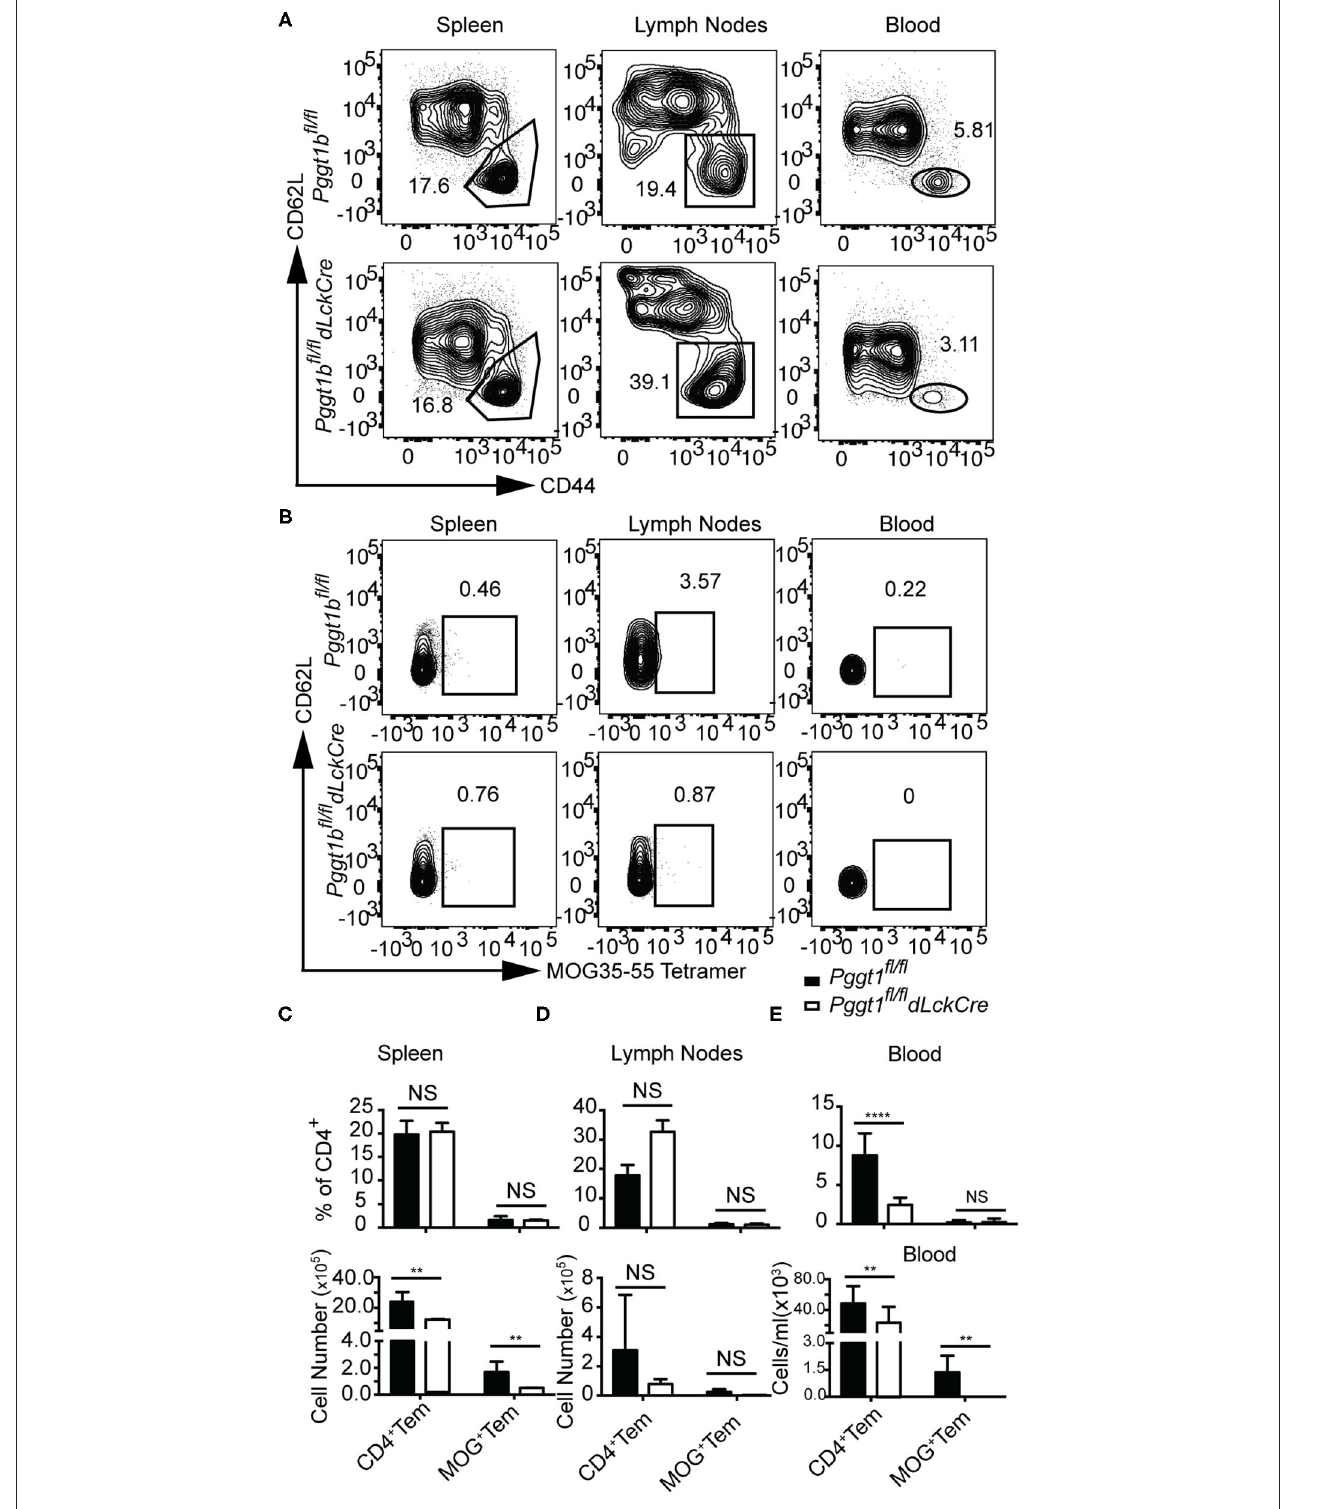
FIGURE 6 | Defective effector T cell egress from secondary lymphoid organs after primary immunization in Pggt1b fl / fl dLckCre mice. (A) Flow cytometry analysis of effector (CD44 high , CD62L low ) CD4 + T cells in the spleen, draining lymph nodes and blood 7 days after immunization; (B) Flow cytometry analysis of MOG-specific CD4 + effector T cells in spleen, lymph nodes and blood 7 days after immunization; absolute number of CD4 + effector cells and MOG-specific CD4 + effector T cells in